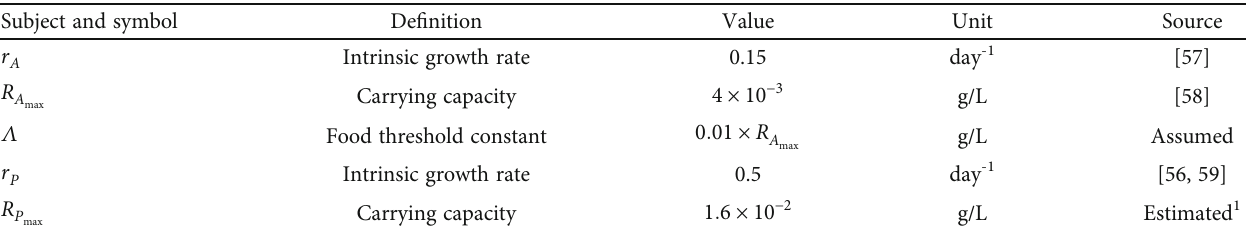
, Nile tilapia, Y , and two food resources, R and R ; solid arrows indicate i i A P Table 3: Parameters for the food resources R and R . A P